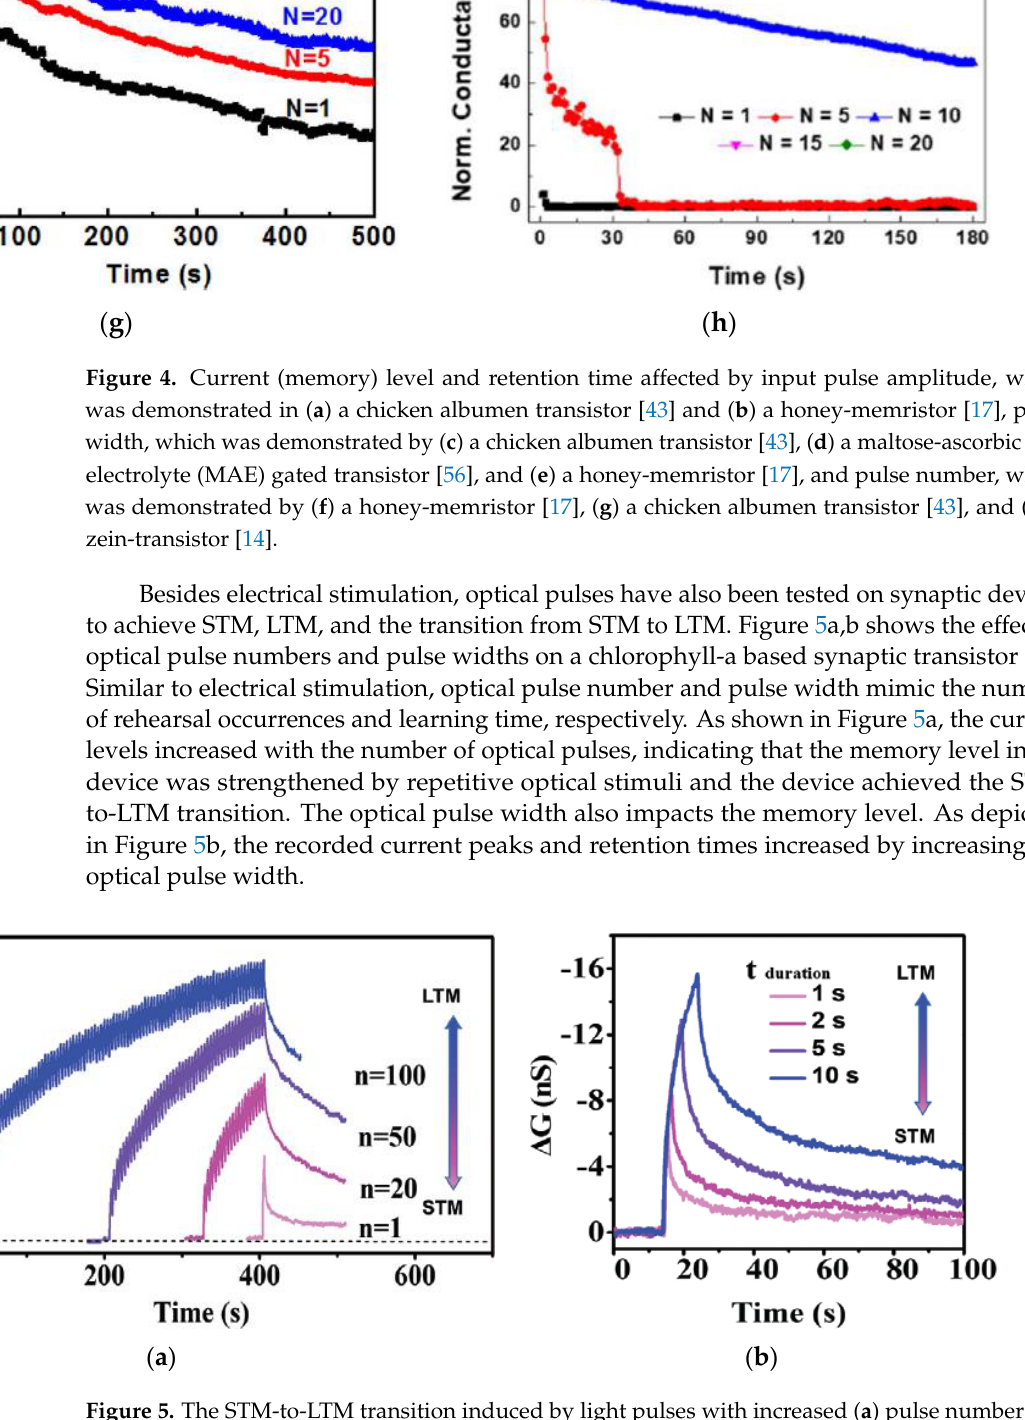
Figure 5. The STM-to-LTM transition induced by light pulses with increased ( a ) pulse number and ( b ) pulse width in a chlorophyll-a based synaptic transistor [57].